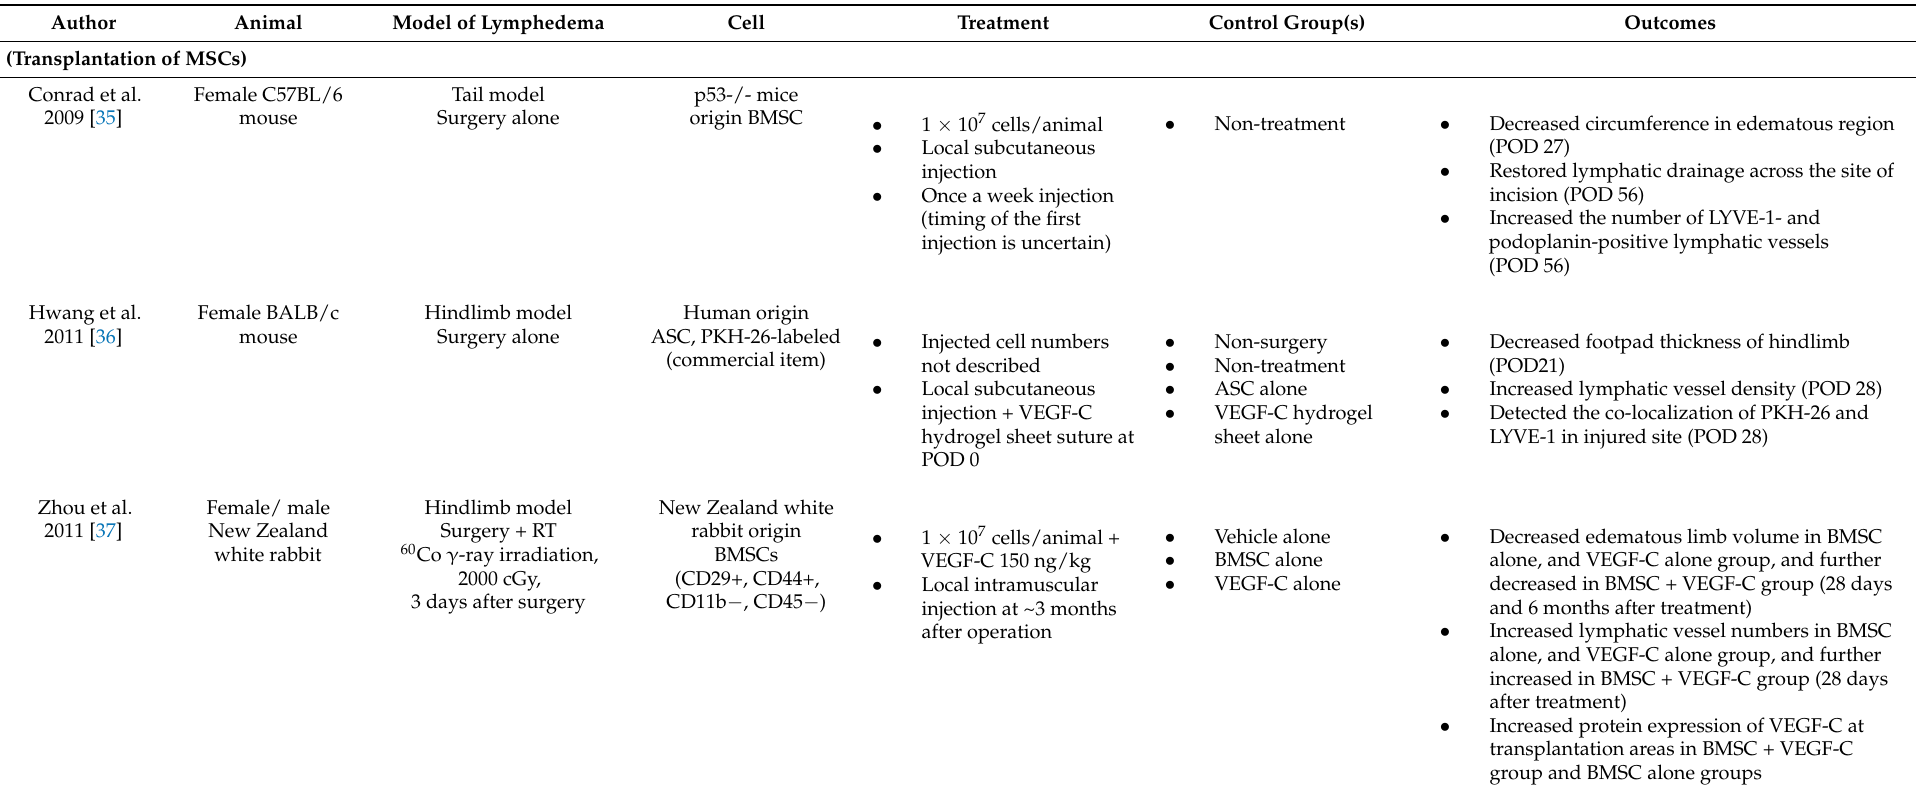
Table 1. Cell-based therapies in animal models of